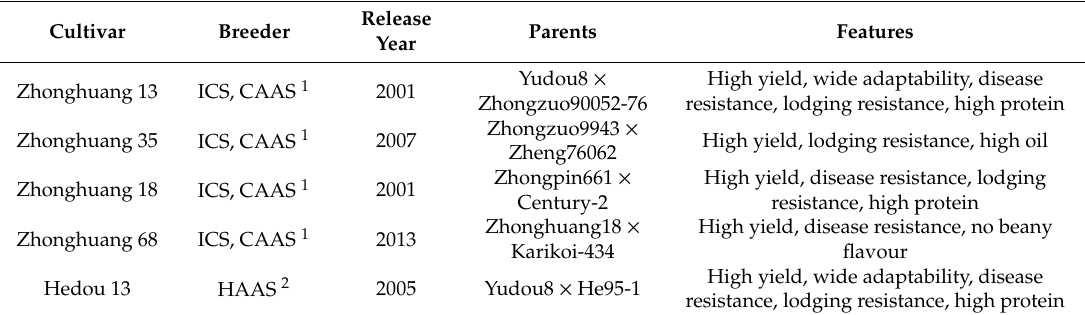
Table 1. The pedigrees of the five